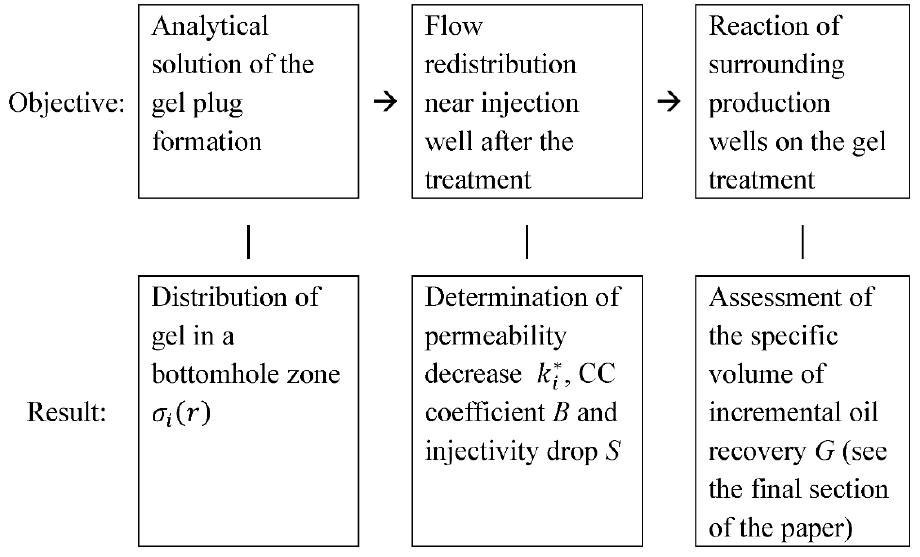
Figure 6. The general workflow to estimate the treatment process parameters.